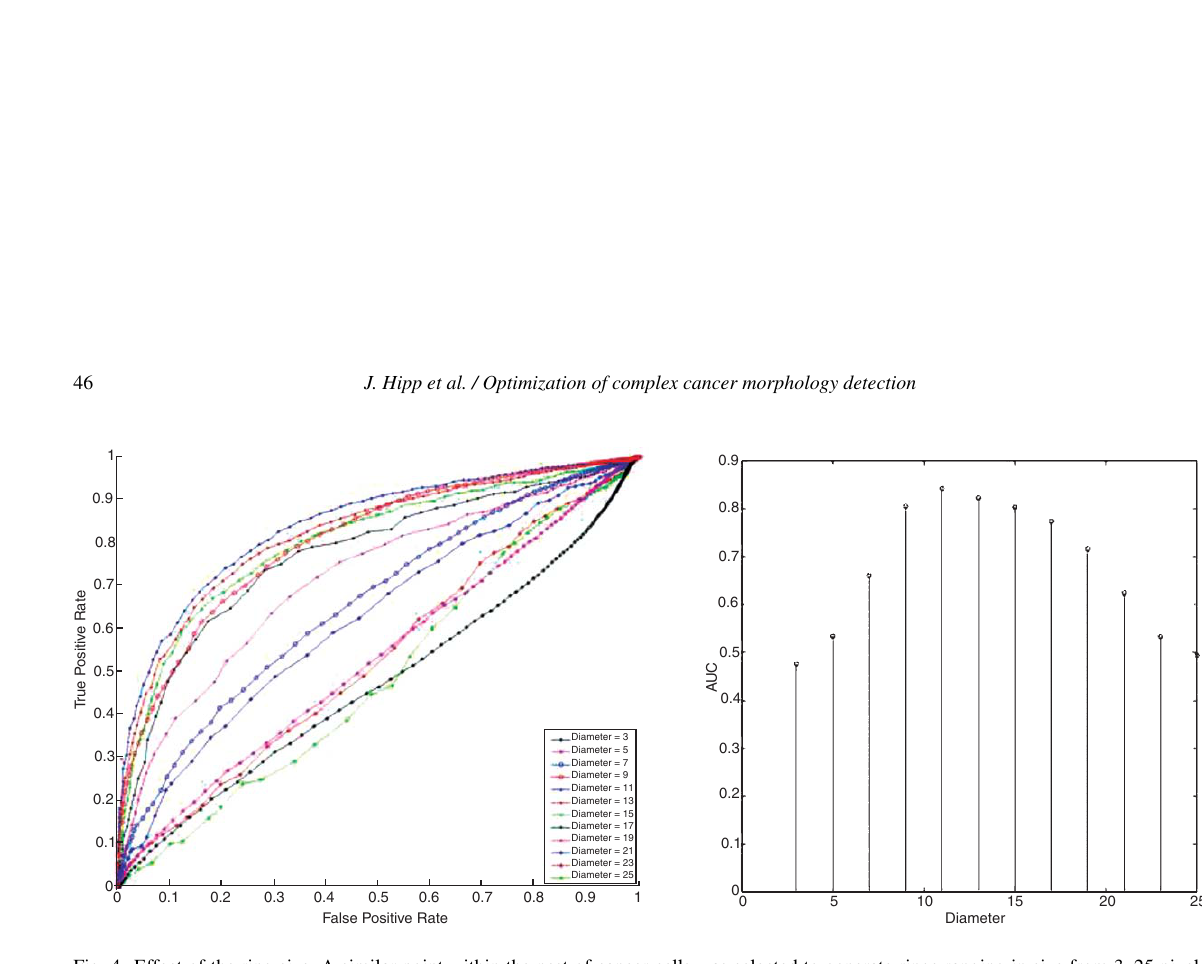
larger vector identified less background cells (inflam- to